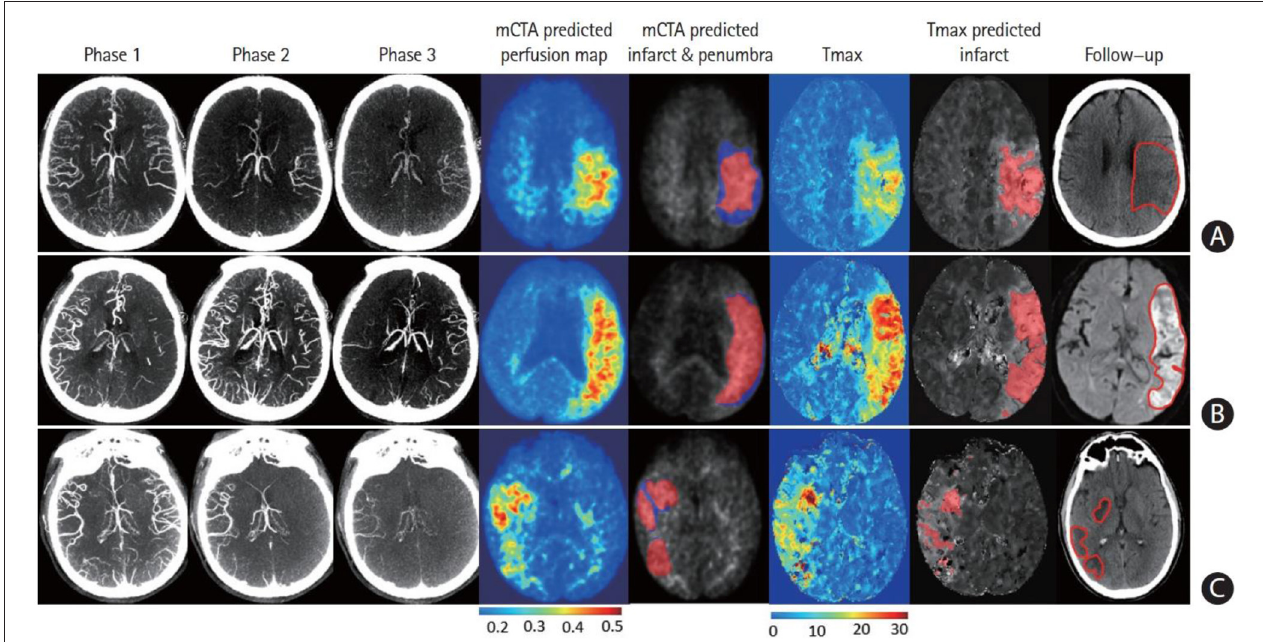
FIGURE 2 | Multiphase computed tomographic angiography (mCTA) predicted an infarct map compared to a computed tomographic perfusion (CTP) time-dependent Tmax threshold map when compared to a follow-up infarct. (A) Patient who achieved reperfusion (mTICI 2b); (B) patient who did not achieve reperfusion; and (C) patient who achieved complete reperfusion with EVT. Columns: mCTA phase 1–3, mCTA predicted perfusion maps, mCTA predicted core (red in column 5) and penumbra (blue in column 5) overlaid on the mCTA predicted perfusion map, CTP Tmax maps, CTP time-dependent Tmax threshold predicted infarct, infarct contoured in follow-up imaging, respectively. The penumbra is shown as affected tissue from the penumbra model minus affected tissue from the core model. [Reprinted with permission from Journal of Stroke, 2021